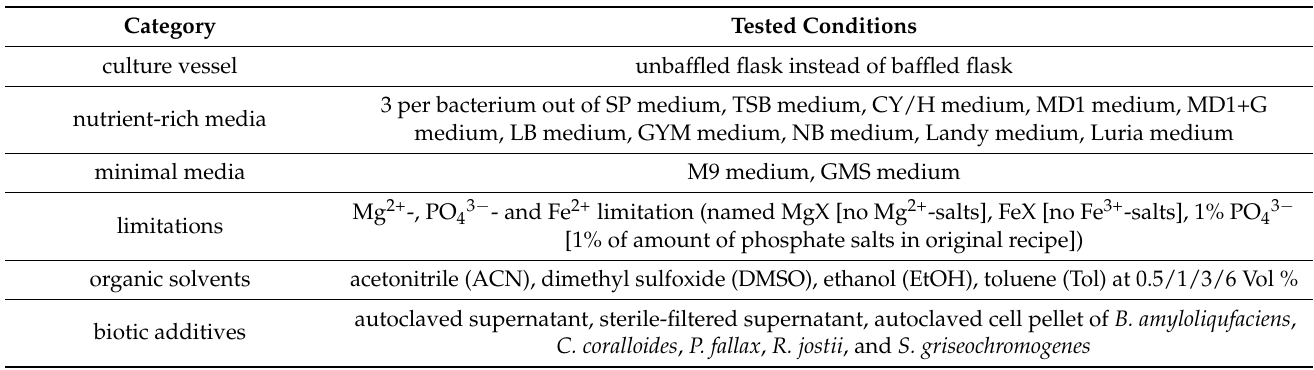
Table 2. Summary of tested OSMAC culture conditions used in this study. Tryptic Soy Broth (TSB), Lysogeny Broth